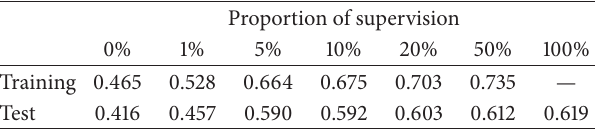
Table 3: Comparison of recognition rates in preliminary experi- ment ( Cora ).